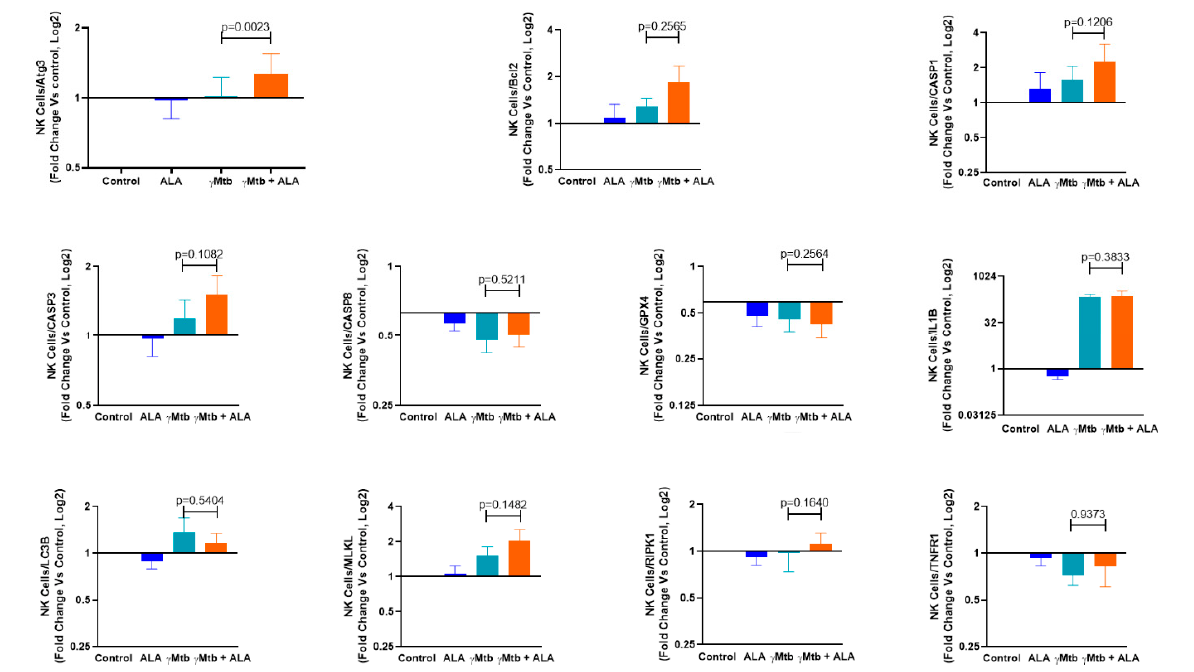
Figure 6. ALA inhibits antimicrobial peptide expression and enhances Atg3 expression in γ Mtb cultured NK cells. PBMCs of healthy LTBI+ donors were cultured with or without γ Mtb (10 µg/mL) and in the presence or absence of ALA, as mentioned in the Methods section. After 48 h, NK cells were isolated via flow sorting, RNA was collected, and real-time PCR analysis was performed to determine various death pathway gene expressions. PBMCs from six LTBI+ donors were used for this experiment. Paired t -tests were used to compare the differences between untreated and treated PBMCs from the same samples. The p values are shown in the fi gure.